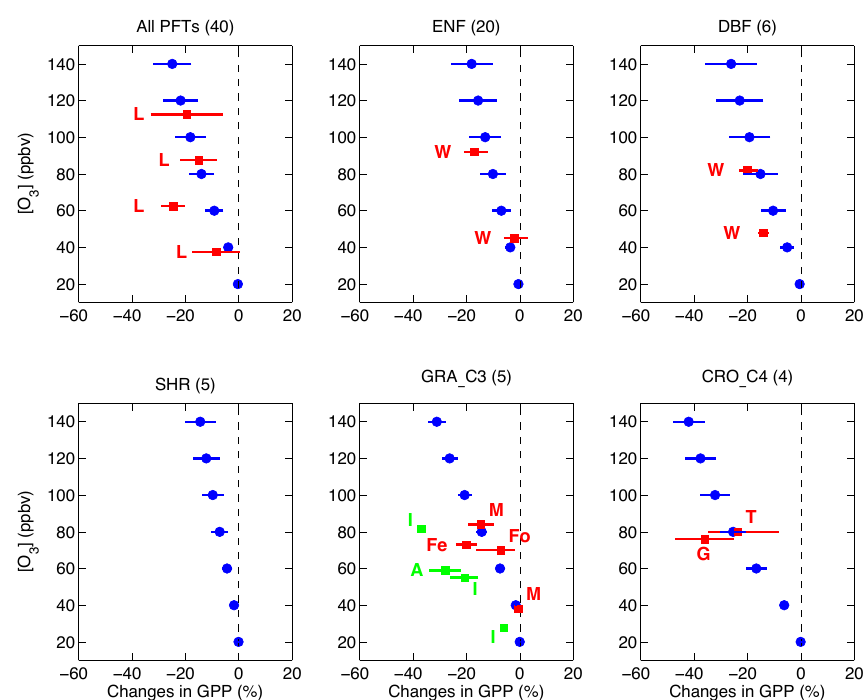
Figure 6. Percentage change in GPP (%) averaged across all sites and grouped by individual PFT type in the presence of different levels of [O 3 ] as simulated by the YIBs vegetation model. Simulations are performed at 40 NACP sites with a prescribed fixed [O 3 ] for either low or high O 3 sensitivity. Blue points indicate the average model reduction with the blue horizontal lines indicating the damage range across low to high O 3 sensitivity. The number of sites used to obtain the average reduction value is shown in the title bracket of each subplot. The solid squares with lines show the results (mean plus uncertainty) based on measurements reported in multiple studies. Measurements include the following: Lombardozzi et al. (2013) for all PFTs; Wittig et al. (2007) for evergreen needleleaf forest (ENF) and deciduous broadleaf forest (DBF); C4 grass or crop (CRO_C4) from Taylor et al. (2002) for spartina alterniflora and Grantz et al. (2012) for sugarcane hybrids; C3 grass or crop (GRA_C3) from Feng et al. (2008) for wheat, Foot et al. (1996) for colluna vulgaris , Mulchi et al. (1992) for soybean, and Ishii et al. (2004) and Ainsworth (2008) for rice. Values for rice are denoted in green and others in red. The author initials are indicated for the corresponding studies.